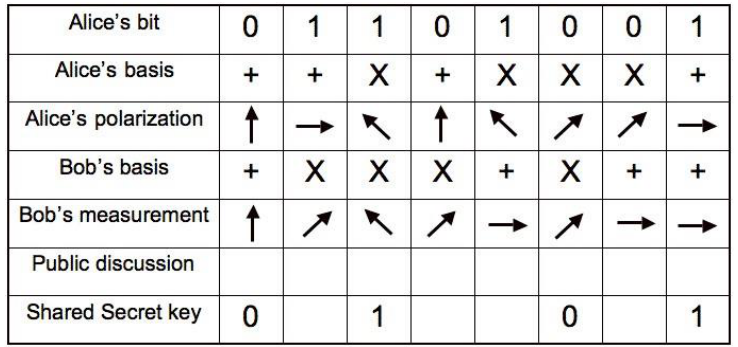
Figure 2. Sifted